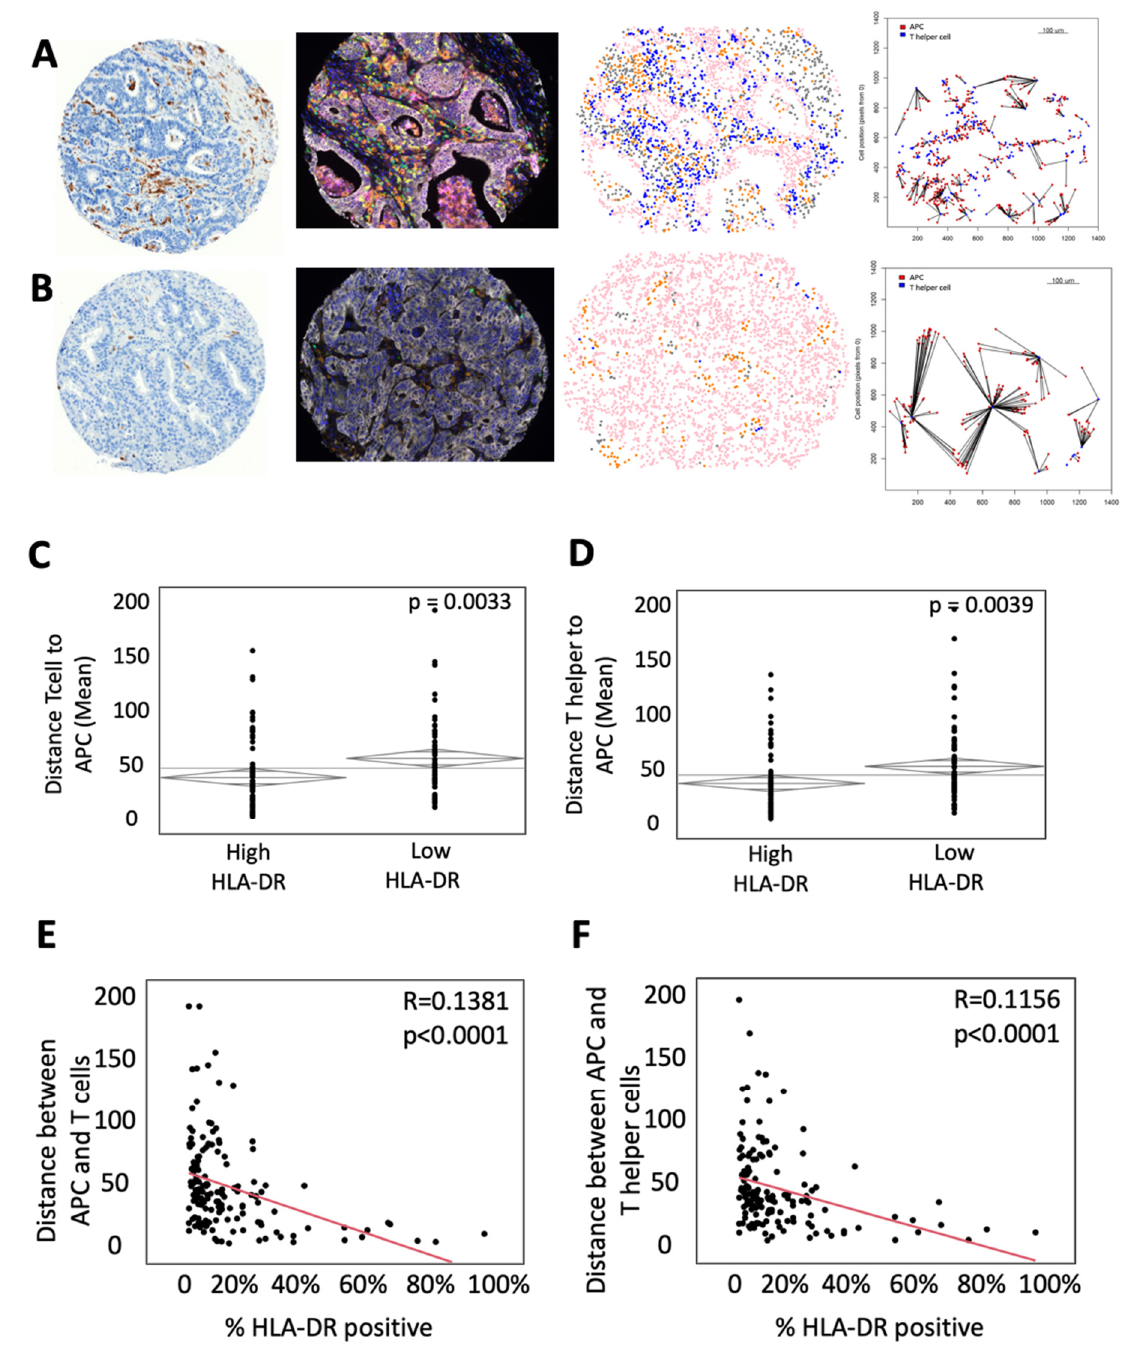
Figure 1. High HLA-DR expression is associated with decreased distance between T helper cells and antigen-presenting cells (APCs). ( A ) Representative example of a tumor with high HLA-DR expression (Left to right: (a) immunohistochemistry for HLA-DR, (b) composite multiplex immuno- histochemistry image stained for CD3—green, CD163—orange, CD8—yellow, pancytokeratin—white, FoxP3—red, PD-L1—magenta, and DAPI—blue, (c) phenotypic map depicting the location of CD3 + T cells (blue), pancytokeratin-positive epithelial cells (pink), CD163 + APCs (orange) and other cells (gray), (d) nearest neighbor analysis between APCs (red) and T helper cells (blue). ( B ) Representative example of a tumor with low HLA-DR expression with images as described above. ANOVA analysis of the mean intercellular distance between ( C ) APCs and T cells and ( D ) APCs and T helper cells. Bivariate comparison of percentage of HLA-DR positivity by surface area and intercellular distances between ( E ) APCs and T cells and ( F ) APCs and T helper cells.